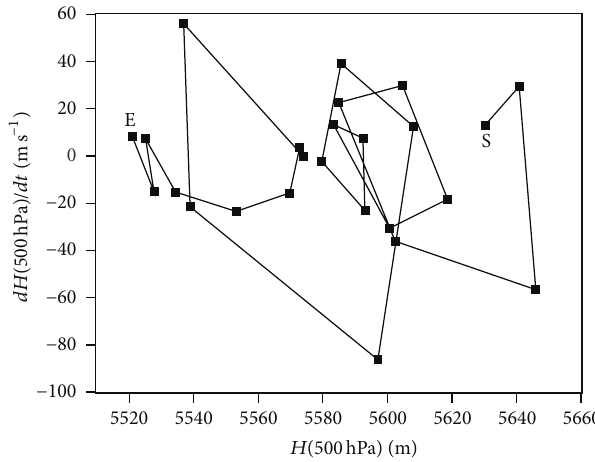
Figure 10: Phase diagram of 500 hPa planetary-scale heights for January 23–February 16. Each point represents a day. S = start and E = end.